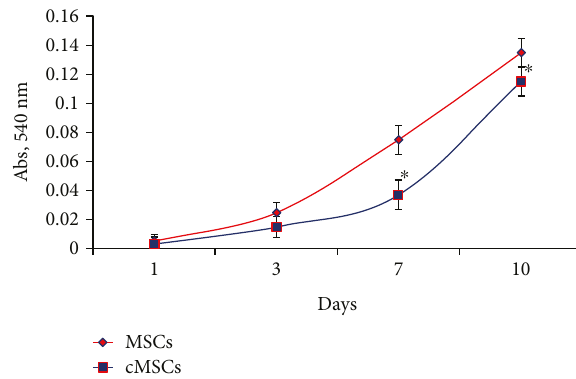
Figure 2: Proliferation of MSCs after cryopreservation. On the fi rst passage, cMSCs were characterized by a lower proliferation rate, and on the 10th day, they reached only 65% of con fl uent versus 80% density of monolayer in cultures without cryopreservation. ∗ Statistically signi fi cant di ff erence relatively to MSCs at the same term of cultivation ( p < 0 05